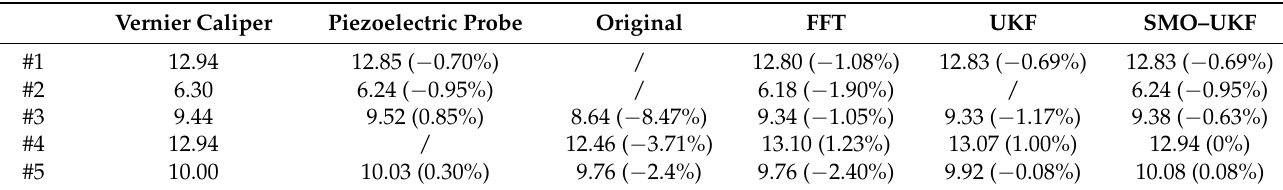
Table 2. Comparison results for different specimens (unit: mm).